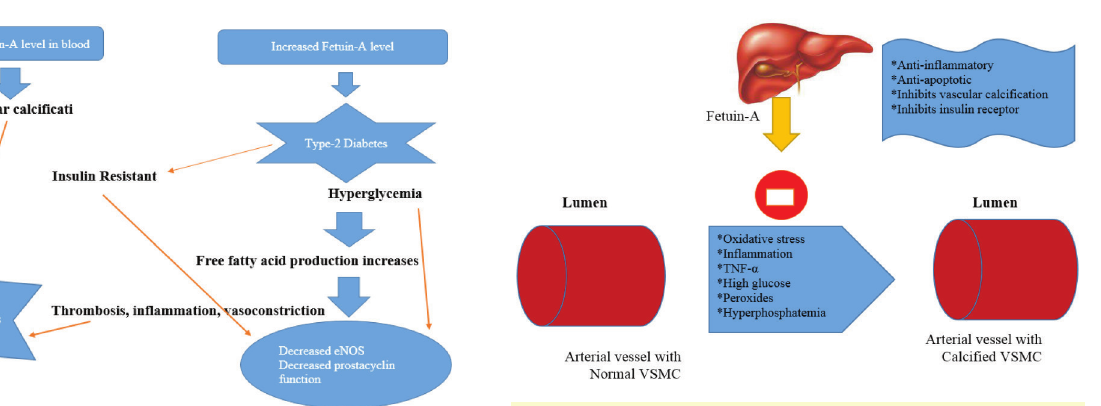
Figure 3 . Fetuin-A multi-functions and its relationship with inflammation